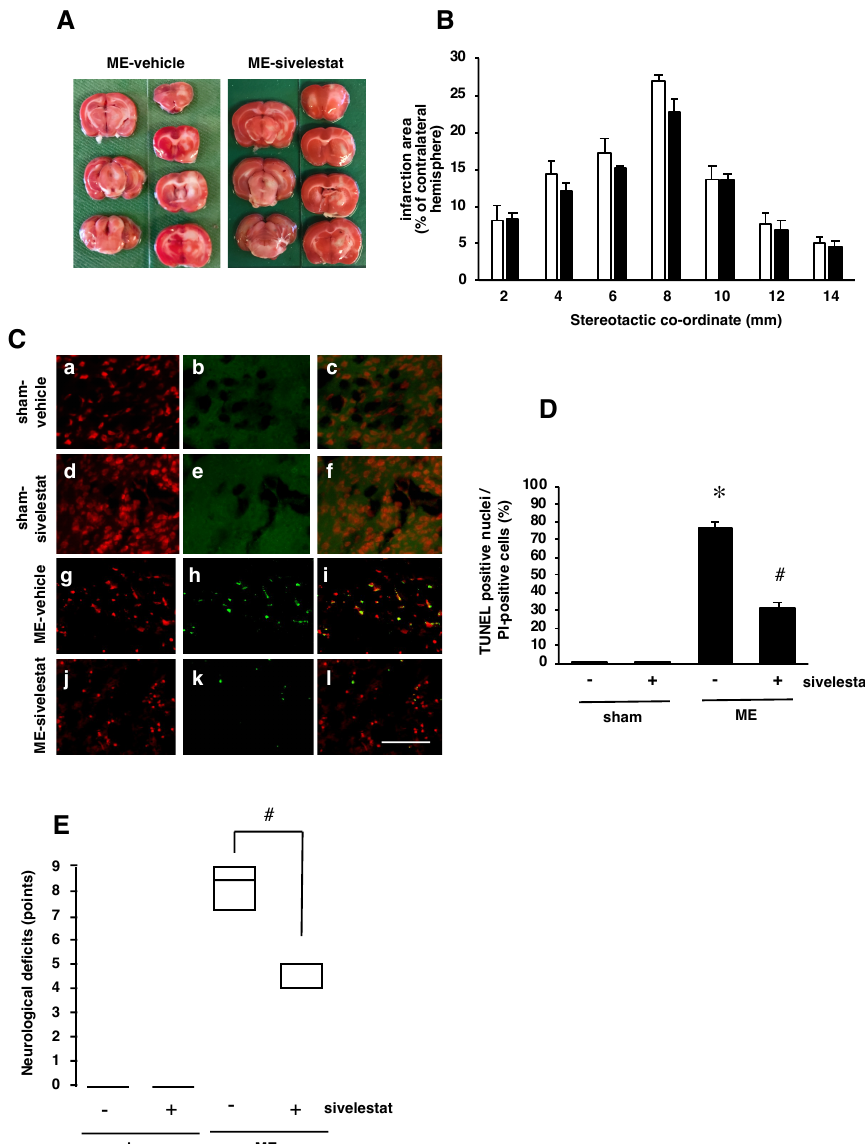
Figure 7. ( A ) Representative photographs of 2,3,5-triphenyltetrazolium chloride (TTC) staining from vehicle- and sivelestat-treated ME rats; ( B ) The infarct area of hemispheres at 2, 4, 6, 8, 10, 12, and 14 mm from the forebrain in the vehicle-treated ME groups (white bars) and sivelestat-treated ME groups (black bars) on day 1 after surgery. The infarct areas are expressed as percentages of the contralateral hemisphere. Values represent the means ± SD ( n = 5 each); ( C ) images of double staining (merge, c, f, i, and l) with PI (red, a, d, g, and j) and TUNEL-positive nuclei (green, b, e, h, and k) for the vehicle-treated sham, ME groups, sivelestat-treated sham, and ME groups on day 1 after surgery. The scale bar represents 50 µm; ( D ) Effect of sivelestat administration on the number of TUNEL-